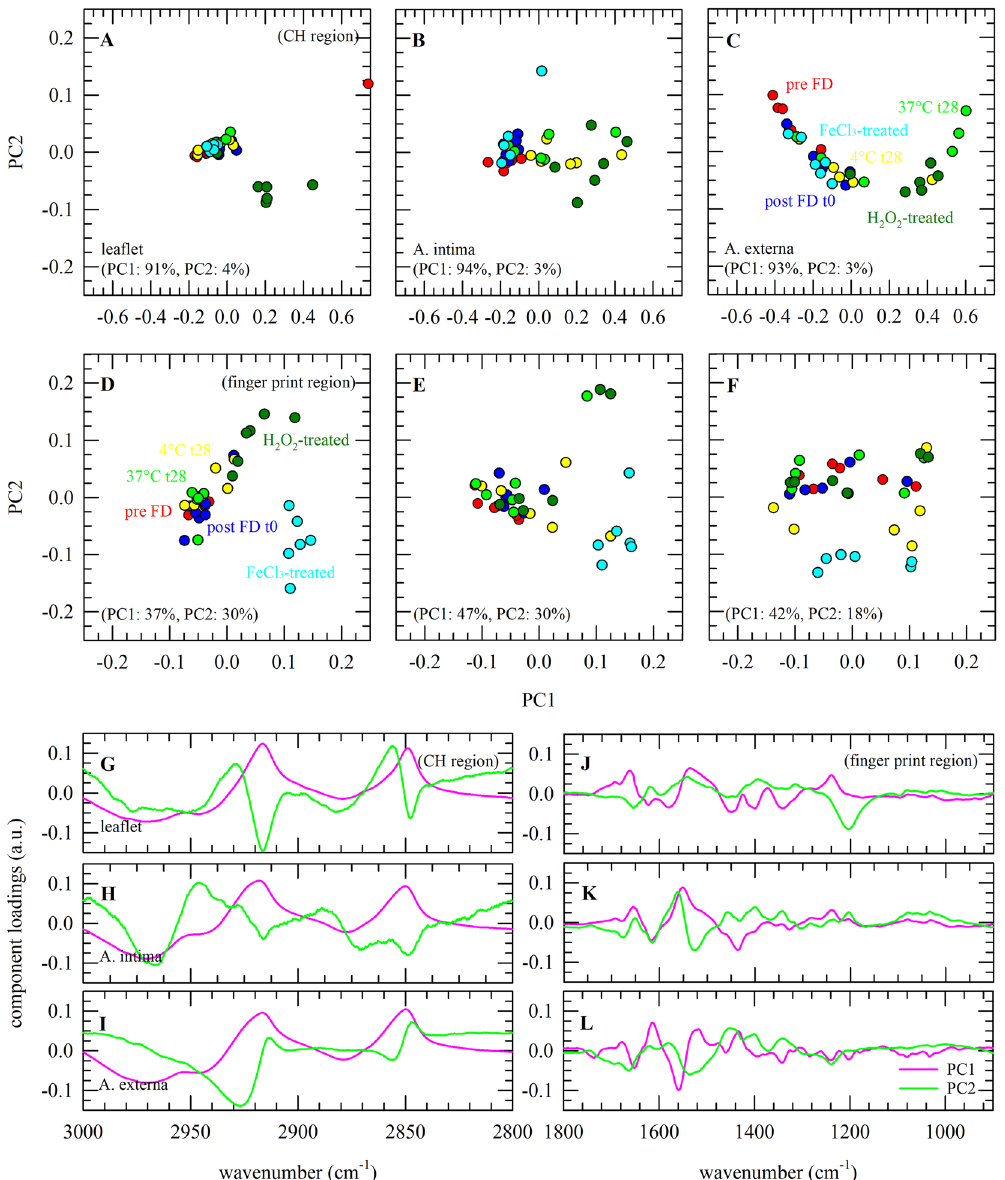
Figure 5. Application of principal component analysis (PCA), for classification of infrared spectra of decellularized heart valve tissues subjected to freeze-drying and dried storage, as well as induced oxidative stress. Analysis was done for the leaflet ( A , D , G , J ), intima ( B , E , H , K ) and externa ( C , F , I , L ) artery layers. PCA was performed for the CH stretching region ranging from 3000 to 2800 cm −1 ( A – C , G – I ) and the 1800–900 cm −1 spectral range containing protein specific absorbance bands and the fingerprint region ( D – F , J – L ). In all cases specimens were analyzed before (red symbols) and after freeze-drying (dark blue symbols), after 1 month storage at 4 °C (yellow symbols) and 37 °C (light green symbols), as well as specimens exposed to H 2 O 2 (dark green symbols) and FeCl 3 -treatment (light blue symbols). For both spectral regions, score values of PC1 were plotted versus PC2 ( A – F ). In addition, loadings plots of PC1 and PC2 were constructed ( G – L ). Measurements and analysis were done using six specimens for each sample